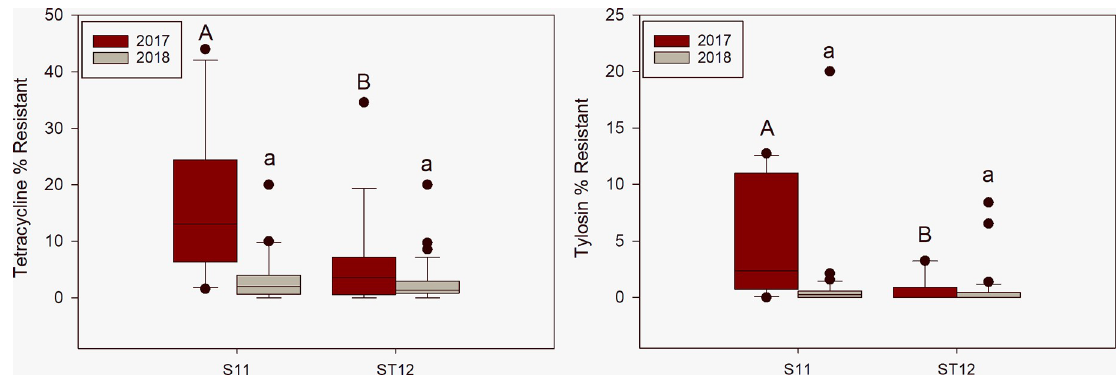
Fig 2. Box-plots of tetracycline and tylosin percent resistant enterococci for the manure comparison. The middle line on the box-plot represents the median while the upper quartile of the box represents the 75 th -percentile and the lower quartile the 25 th -percentile. The whiskers denote the range of the quartiles and outliers are marked as dots. The letters above each plot represent significant differences based on the Wilcoxon Rank-Sum Test. Capital letters are associated with 2017 and lower-case letters are associated with 2018. Differing letters mean significant difference between groups (p < 0.05).